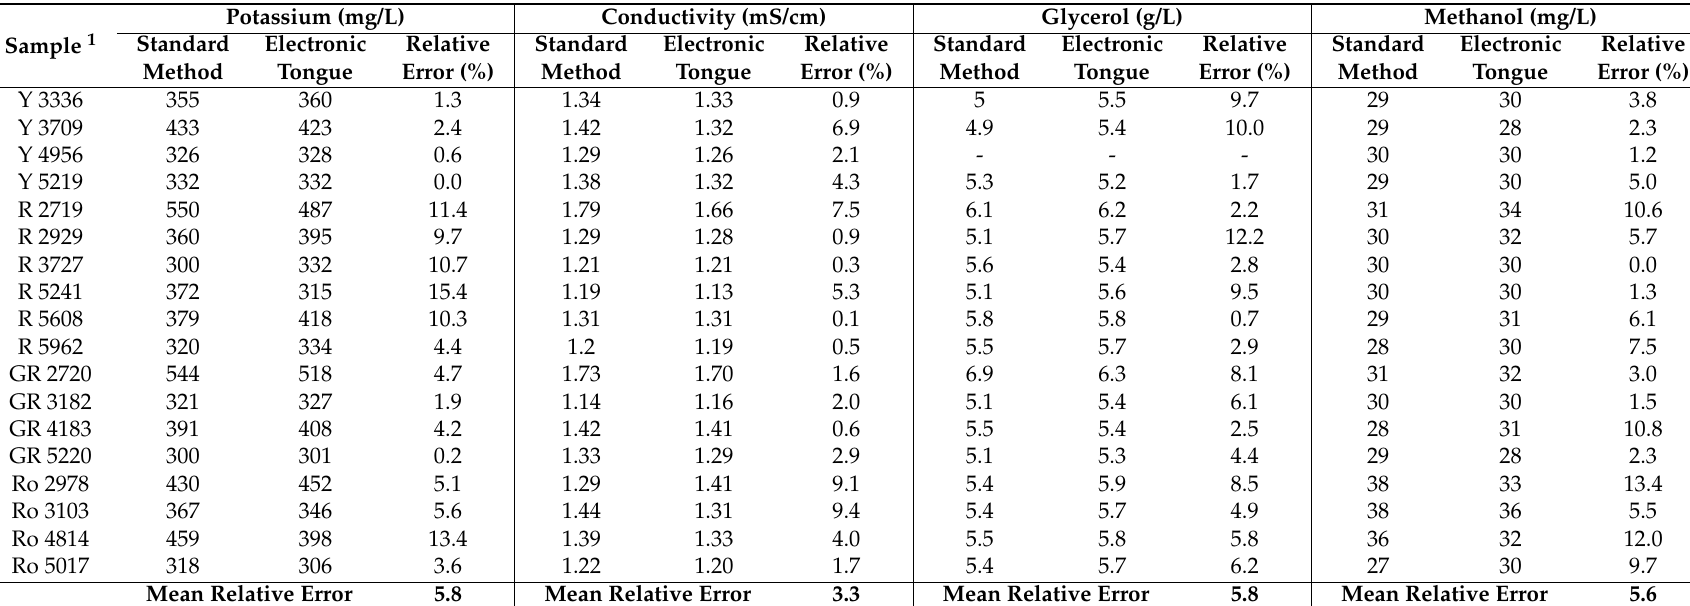
Table 5. Results of quality parameter quantification with the electronic tongue using PLS-1. Standard method data were provided by